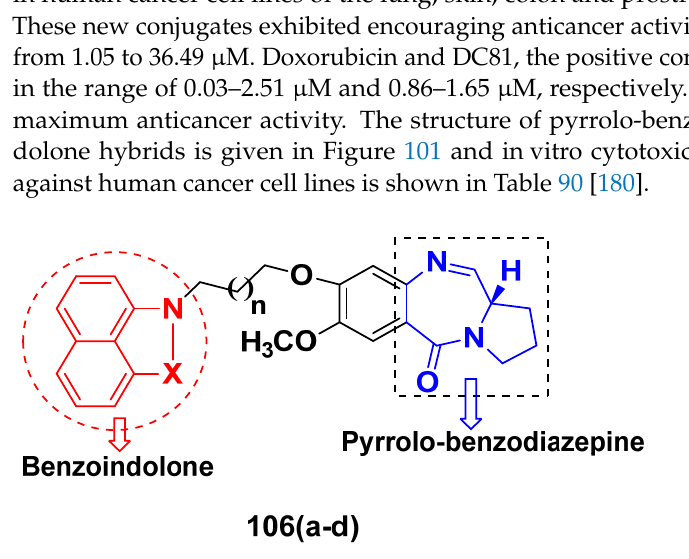
Figure 101. Structure of pyrrolo-benzodiazepine-based benzoindolone derivative ( 106 ). Table 90. In vitro cytotoxic activities of pyrrolo-benzodiazepine-based benzoindolone compounds 106 ( a – d ).